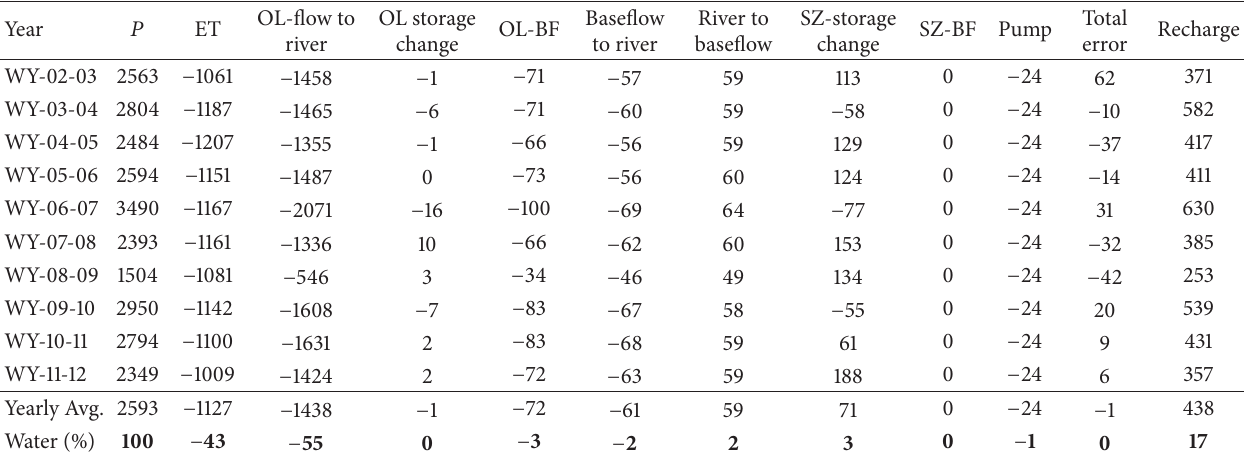
Figure 11: Calibration of groundwater levels within Aquifer 186 using Obs. well #204. Table 5: Simulated total water balance for each water year (WY) and yearly averages